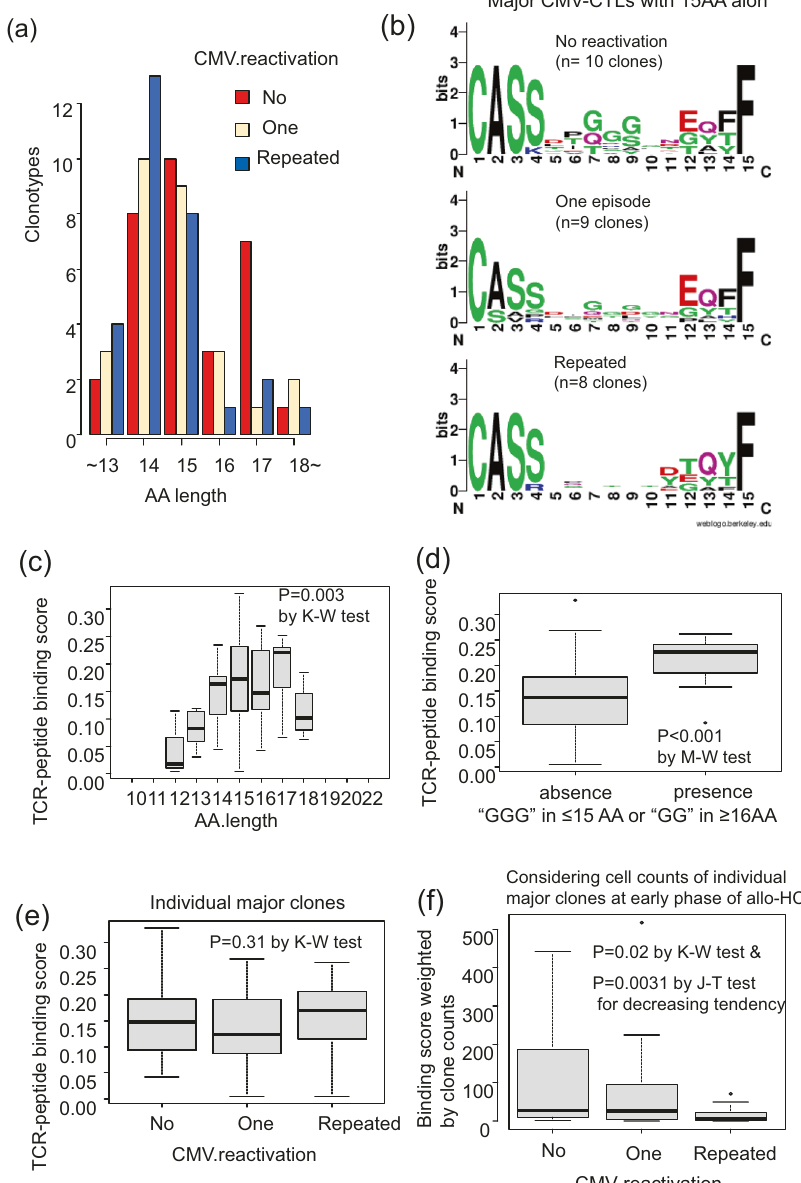
Fig. 2 Amino acid (AA) sequence logos and AA length in the major HLA-A24-restricted CMV-pp65-speci fi c cytotoxic T-cell (CMV-CTL)